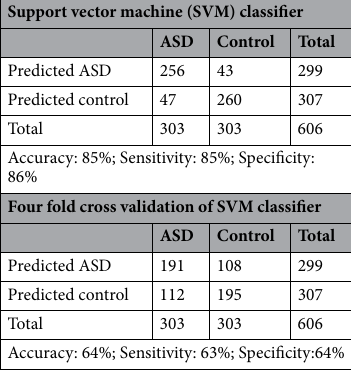
Table 2. SVM classifier and cross validation. A support vector machine classifier using individual age, sex and bilateral habenula volume as input is able to distinguish between ASD and TDC control subjects with 85% accuracy using a balanced dataset created by adding ASD subjects randomly picked from the original 220. The accuracy drops to 64% in a fourfold cross validation where for every quarter of the original dataset, the SVM is trained on the remaining three quarters and applied to the unseen data. ASD, autism spectrum disorder; TDC, typically developing controls; SVM support vector